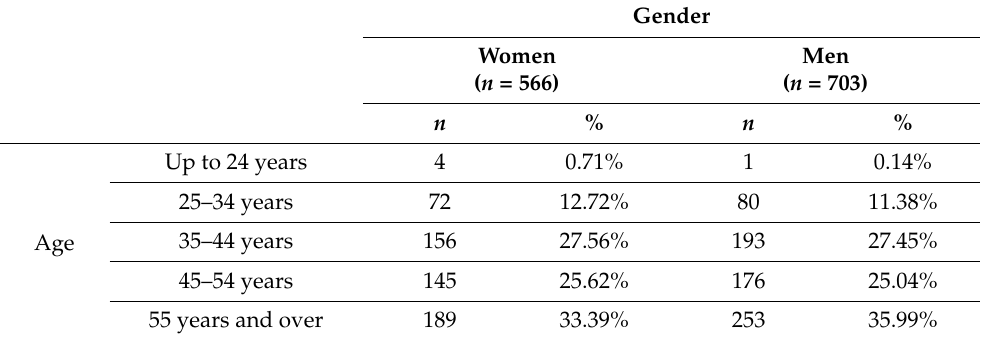
Table 1. Respondents by gender and